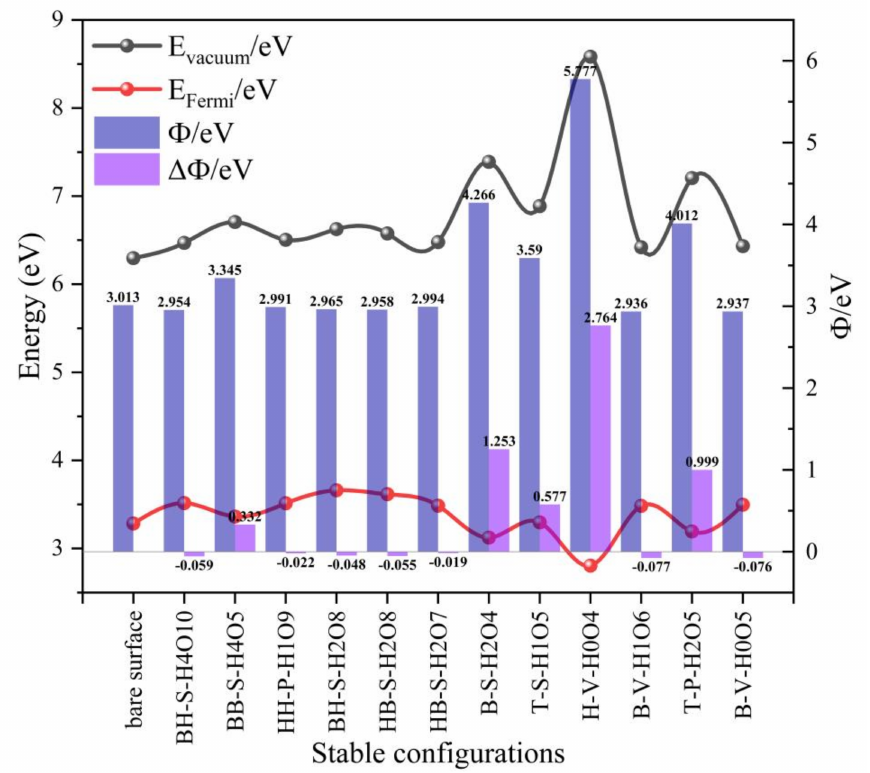
Figure 14. The trend of changes in the surface work function of all stable adsorption configurations after optimization of co-adsorption of O 2 and H 2 O on the δ -Pu (100) surface. ( E vacuum : the distance between H atom and O atom, E Fermi : Fermi level, φ : surface work function ( φ = E vacuum − E Fermi ), ∆ φ : the difference of surface work function between adsorption configuration and pure δ -Pu (100) surface.)